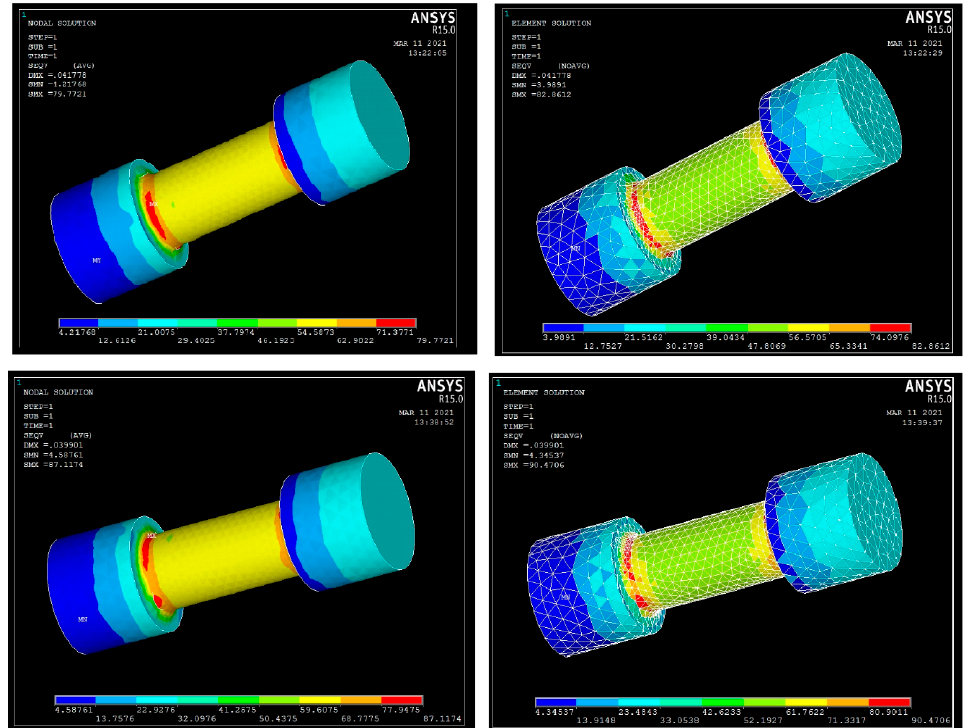
Figure 12. Analysis of nodal and elemental solution plot for compression test on pure Al and composite in ANSYS.